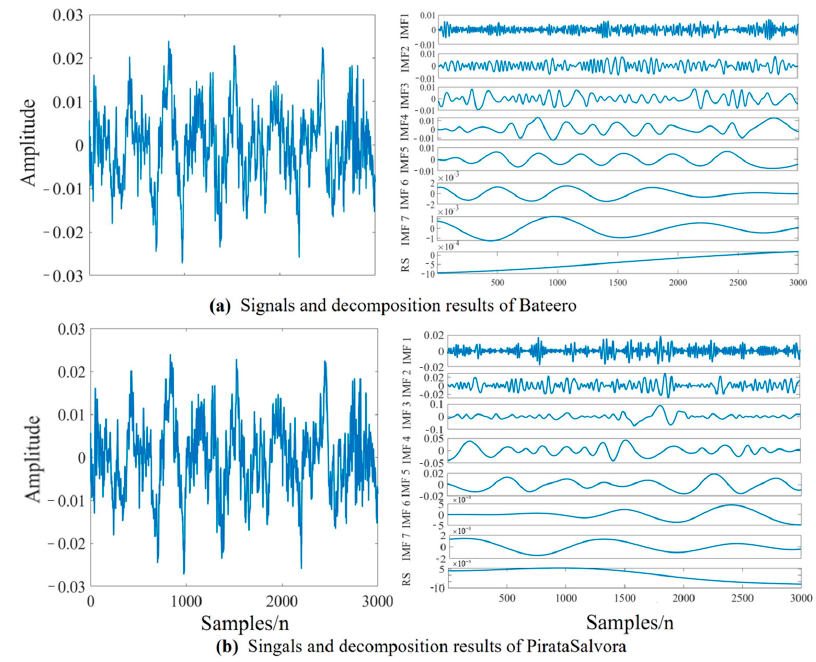
Figure 5. Original sample signals and MEEMD decomposition results: ( a ) Bateero, ( b ) PirataSalvora.